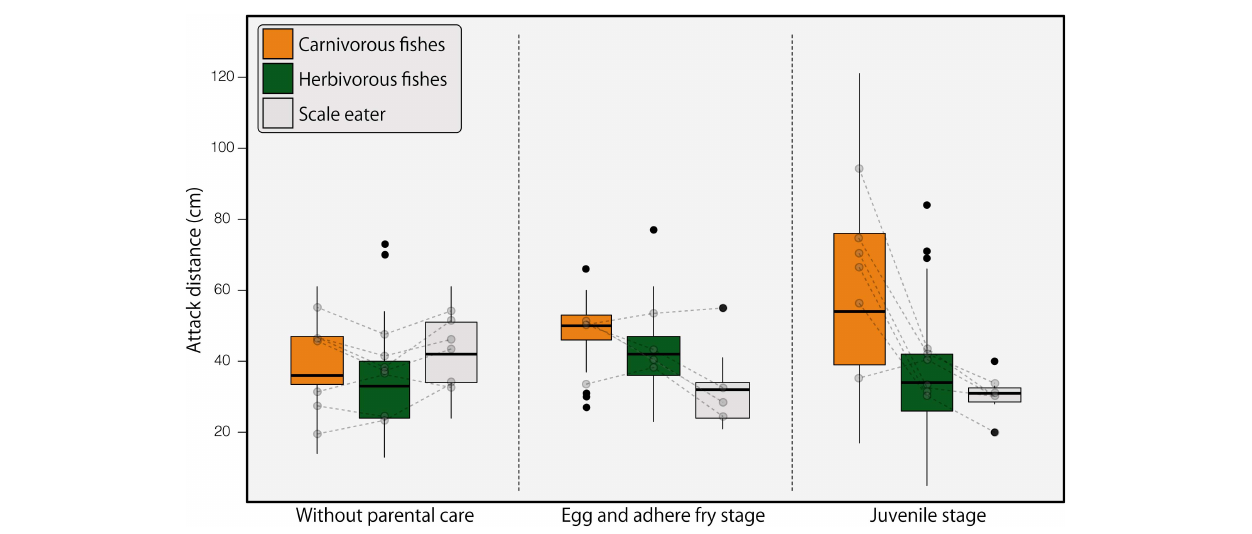
FIGURE 2 | Attack distances of Neolamprologus furcifer females in different parental care stages against different intruder fish types. Box plots show medians and 25th and 75th percentiles; whiskers indicate the values 1.5 times the interquartile range. Black plots are outliers. Gray plot with broken line shows mean attack distance in each